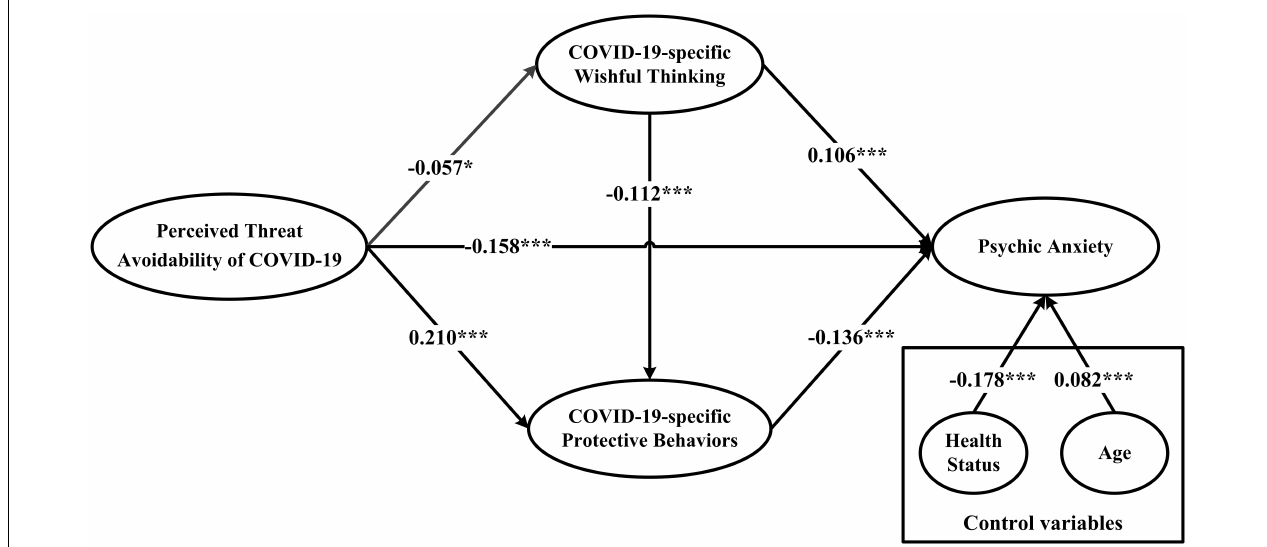
FIGURE 1 | Structural model testing results, Path coefficients are standardized ( N = 2,922; * p < 0.05, *** p < 0.001). χ 2 / df = 5.213, CFI = 0.976, TLI = 0.971, SRMR = 0.046, RMSEA = 0.038. Two control variables (health status and age) were included in the model.